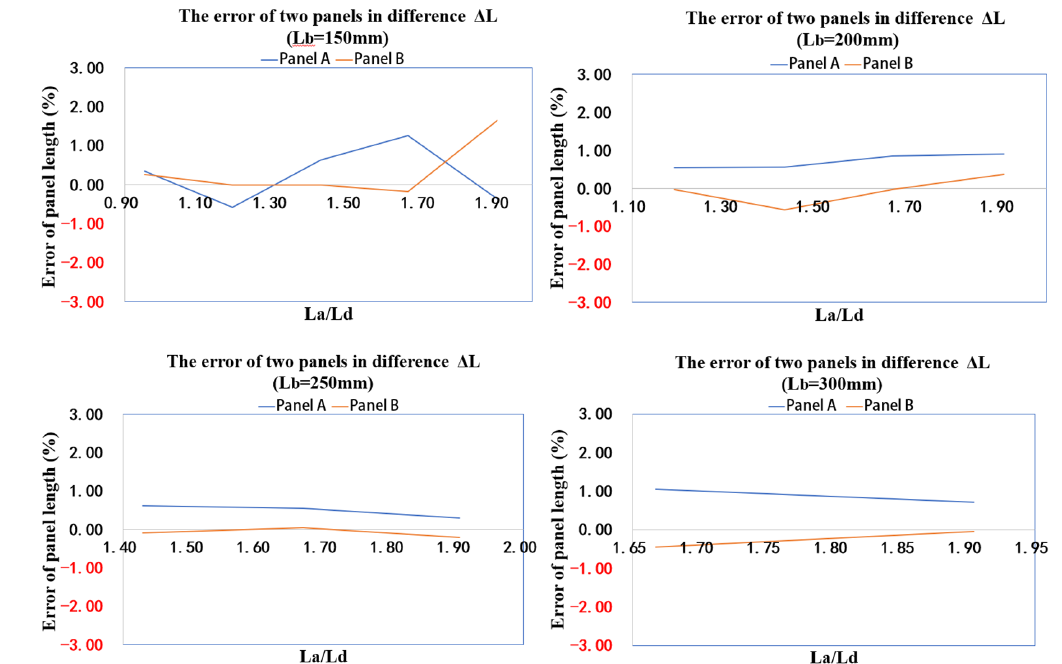
Figure 6. Error analysis of the method.